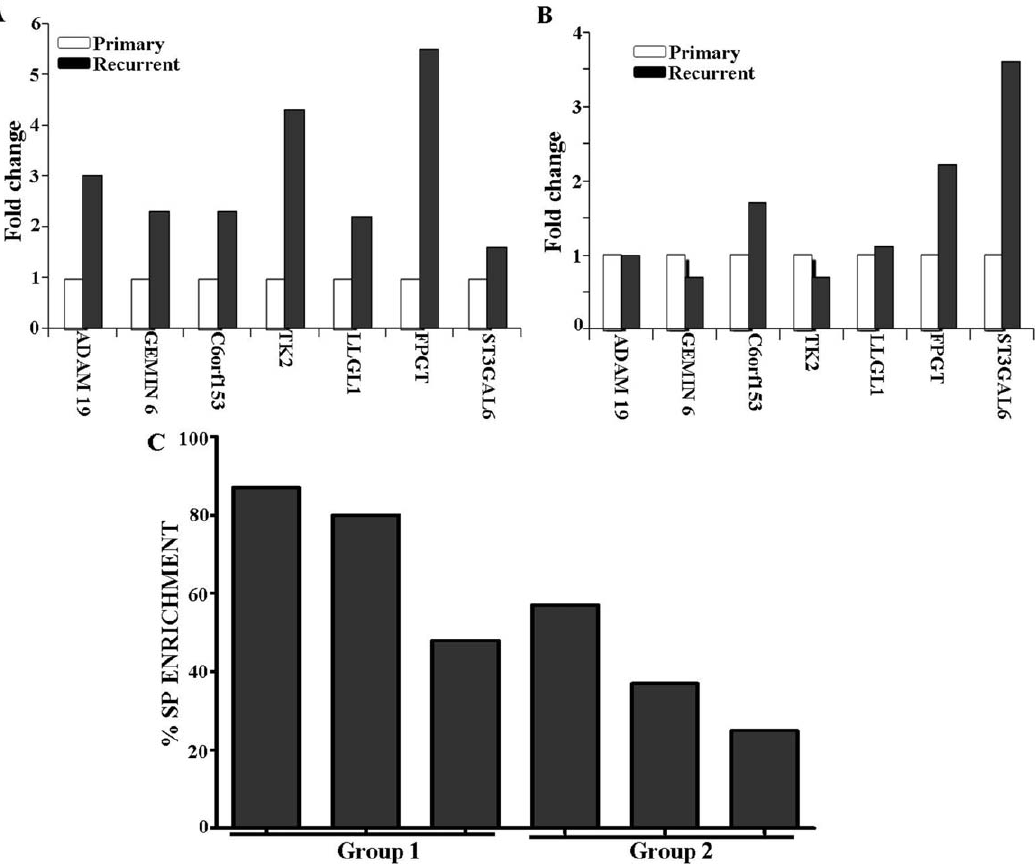
Figure 6. Validation of SP cell signature on ovarian tumor recurrent expression database. (A, B) qRT-PCR Validation of SP cell gene signature in recurrent ovarian cancer specimens. (A) Group 1 consists of tumor recurrence observed between 1 to 12 months and (B) group 2 in between 13 to 24 months. (C) Electronic validation of SP cell gene signature in recurrent ovarian cancer patients.